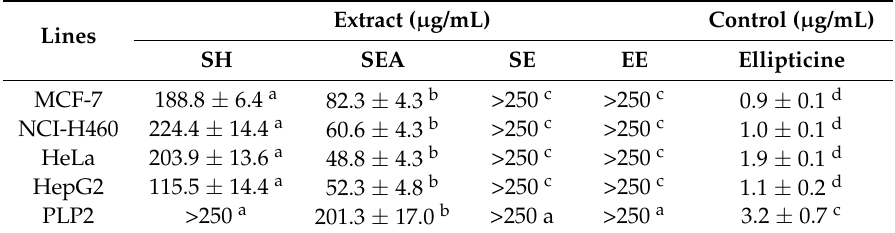
Table 3. Cytotoxicity of neem leaves extracts obtained by PLE against several human cancer cells (MCF-7, NCI-H460, HeLa, and HepG2) and the non-tumor cell (PLP2). All data <250 µ g/mL are reported as a mean ± standard deviation, from growth inhibition at 50% (GI 50 ). Extract ( µ g/mL) Control ( µ g/mL) Lines SH SEA SE EE Ellipticine MCF-7 188.8 ± 6.4 a 82.3 ± 4.3 b >250 c >250 c 0.9 ± 0.1 d NCI-H460 224.4 ± 14.4 a 60.6 ± 4.3 b >250 c >250 c 1.0 ± 0.1 d HeLa 203.9 ± 13.6 a 48.8 ± 4.3 b >250 c >250 c 1.9 ± 0.1 d HepG2 115.5 ± 14.4 a 52.3 ± 4.8 b >250 c >250 c 1.1 ± 0.2 d PLP2 >250 a 201.3 ± 17.0 b >250 a >250 a 3.2 ± 0.7